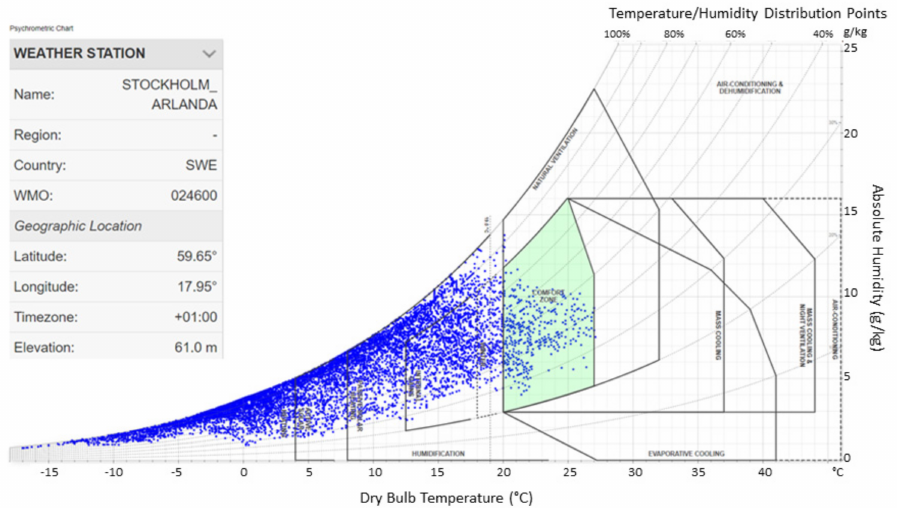
Figure 9. Hourly psychometric chart with Givoni Bioclimatic Chart overlay, Stockholm,